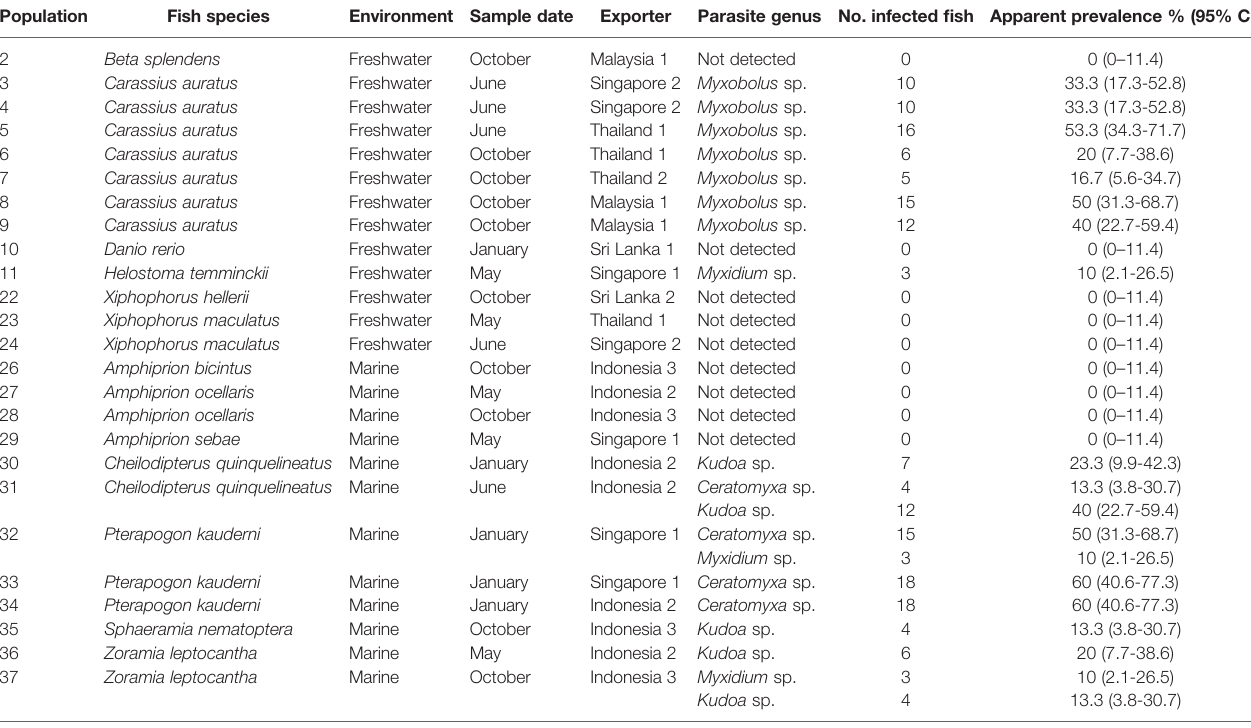
TABLE 2 | Apparent prevalence of myxozoan parasites infecting imported ornamental fi sh.